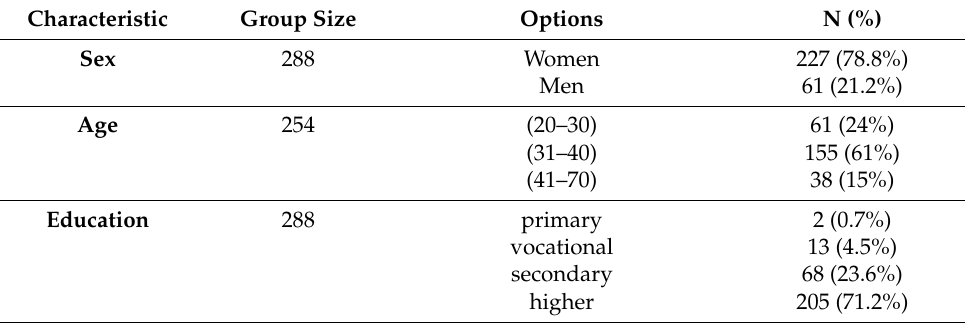
Table 1. Characteristic of the